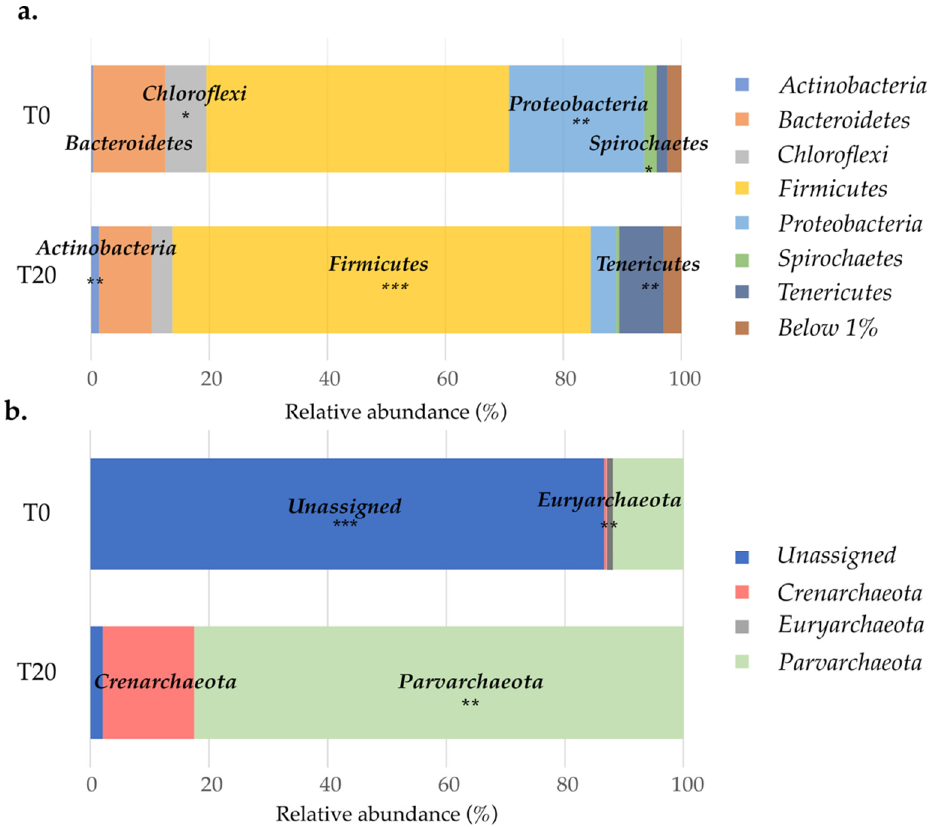
Figure 7. Composition of microbial community present in the anaerobic permeable reactive bio-barrier at the beginning (T0) and after 20 months (T20) of treatment, as determined by DNA-based Illumina sequencing of 16S rRNA of Bacteria ( a ) and Archaea ( b ) at phylum level. Asterisk indicates significant variation of relative abundance during the considered time frame (* = p ≤ 0.05, ** = p ≤ 0.005 and *** = p ≤ 0.0005).